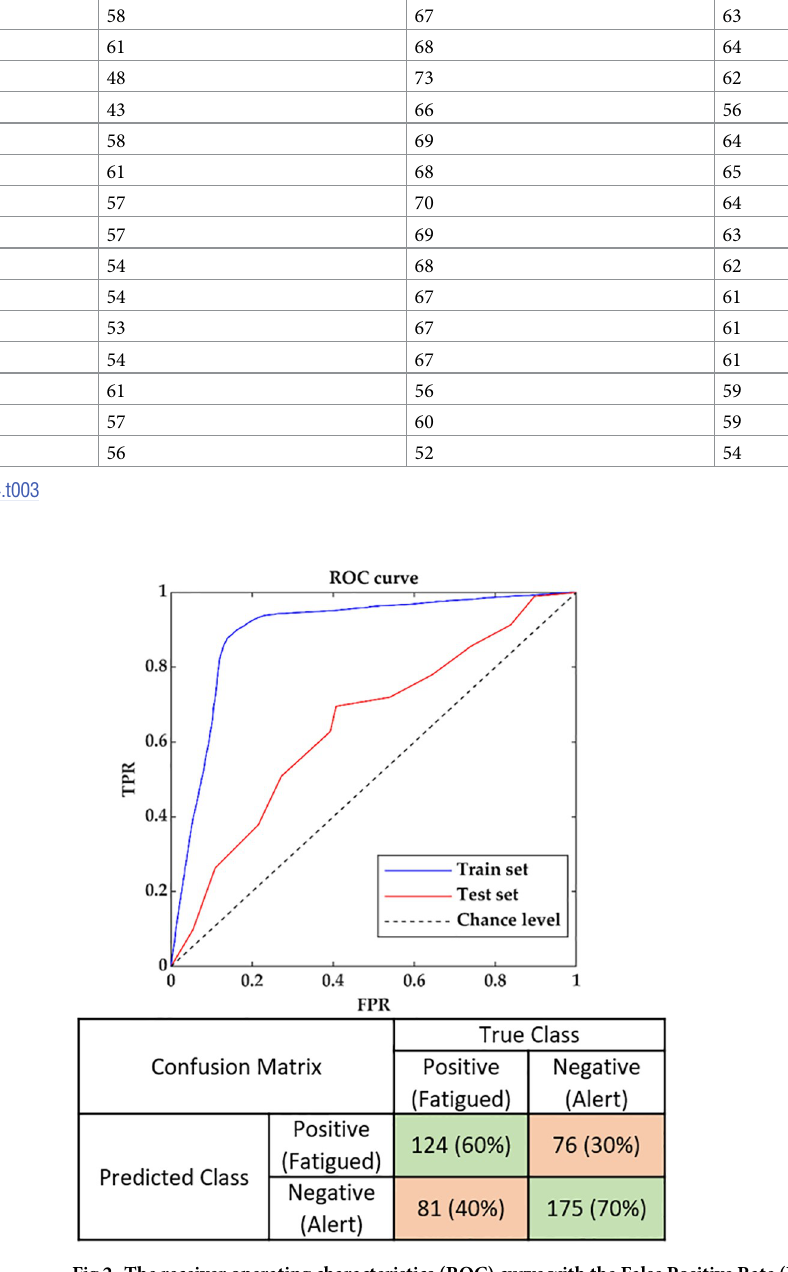
Fig 2. The receiver operating characteristics (ROC) curve with the False Positive Rate (FPR) on the x-axis and the True Positive Rate (TPR) on the y-axis, depicted for the training and test sets, as well as the confusion matrix for the DT Ensemble model. The ROC curve is illustrated by computing the TPR and FPR averaged across the participants for varying values of the posterior probability threshold in [0 1] for the training and test sets. The confusion matrix was computed for the chosen KSS threshold of